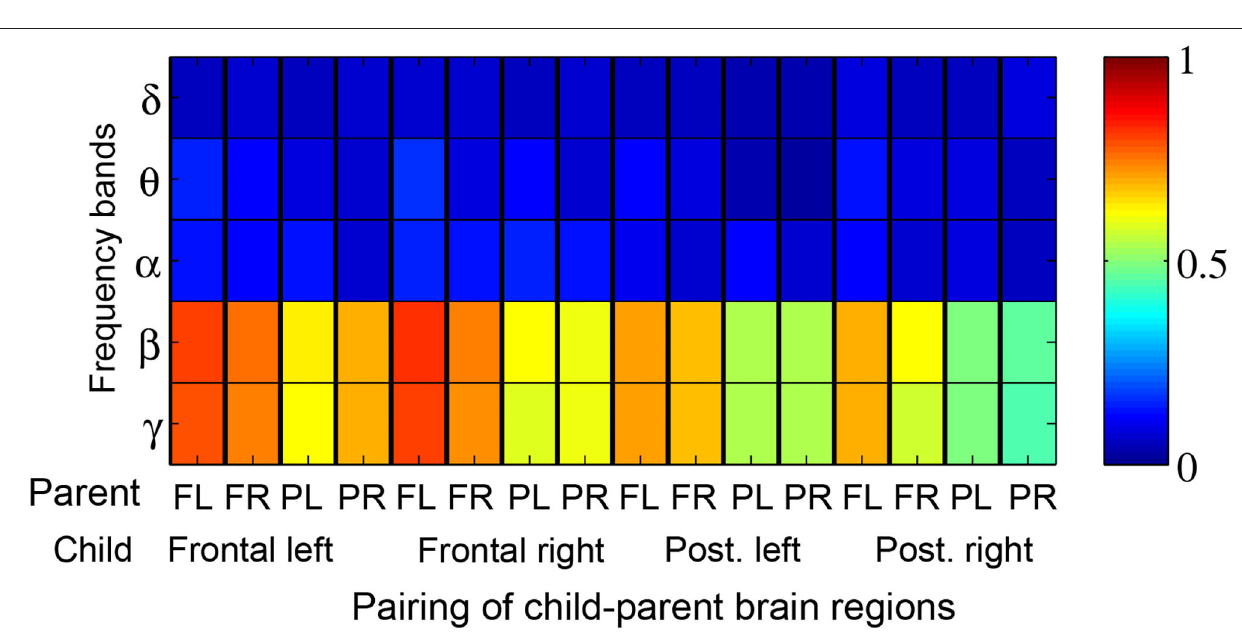
in each other’s presence compared to experiencing the